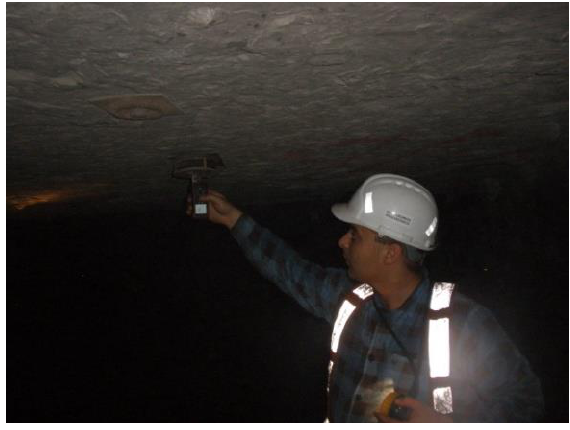
Figure 13. Vertical convergence measurement.